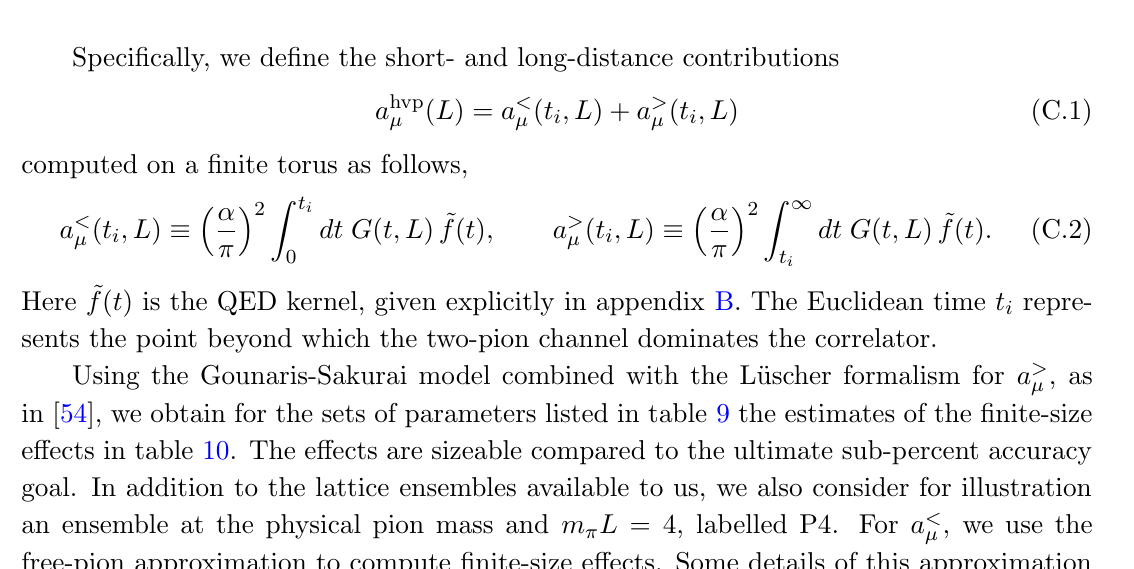
Table 9 . Parameters of the Gounaris-Sakurai model used to explore (cid:12)nite-size e(cid:11)ects on the various ensembles. P4 is a hypothetical ensemble at the physical pion mass. The width parameter at the physical pion mass is taken from [54], and is estimated from there for the other pion masses 1 according to (cid:0) (cid:26) k 3 =m 2 , k (cid:26) ( m 2 4 M 2 ) 1 = 2 . We chose t i = ( m (cid:25) L= 4) 2 =m (cid:25) (cid:26) (cid:26) (cid:26) (cid:0) (cid:25) 2 / (cid:17)